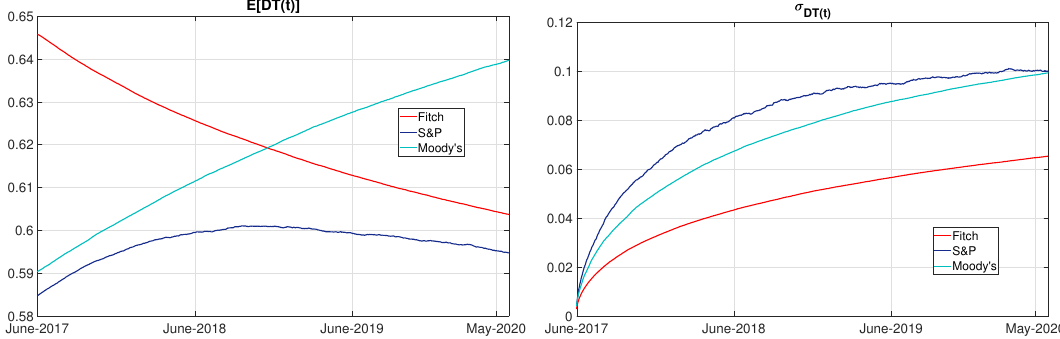
Figure 6. Expected value and standard deviation of DT ( t ) in Brexit